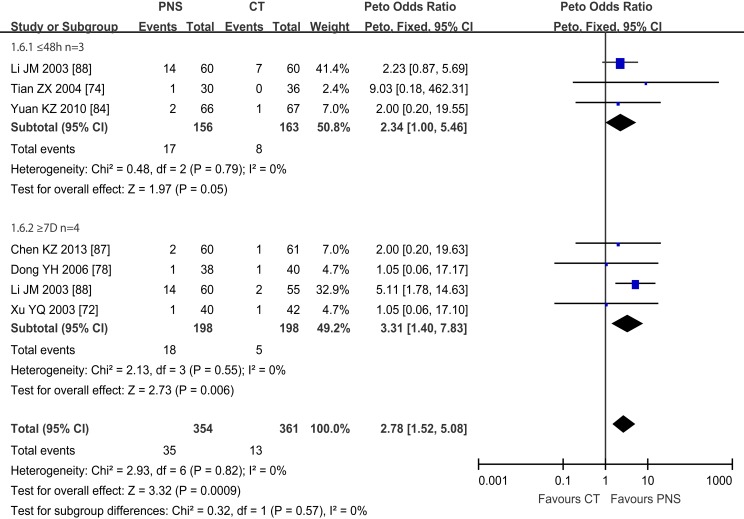
Meta-analyses of number of patients died (NDP) in 6 trials. The total number of patients died (NDP) was 48 out of 715 (6.7%). The mortality of ICH patients was significantly lower in PNS group (13/361, 3.6%) than in CT group (35/354, 9.9%) (Peto OR = 2.78; 95% CI = 1.52, 5.08; P = 0.0009). The trials were divided into two subgroups based on the intervention time of PNS: (1) 3 trials with PNS treatment started within 48 h after ICH onset (Li JM, Tian ZX, Yuan KZ), (2) 4 trials with PNS treatment started 7 days from ICH onset [25, 41, 78, 131] (Chen KZ, Dong YH, Li JM, Xu YQ), One trial (LI JM) had trials started both within 48 h and 7 days after ICH onset. All trials assessed the mortality at the end of treatment course. Both PNS treatment regimes significantly reduced the mortality of ICH patients compared to the CT groups (P = 0.05; P = 0.006, respectively). PNS, Panax notoginseng saponin; CT, Current treatment.